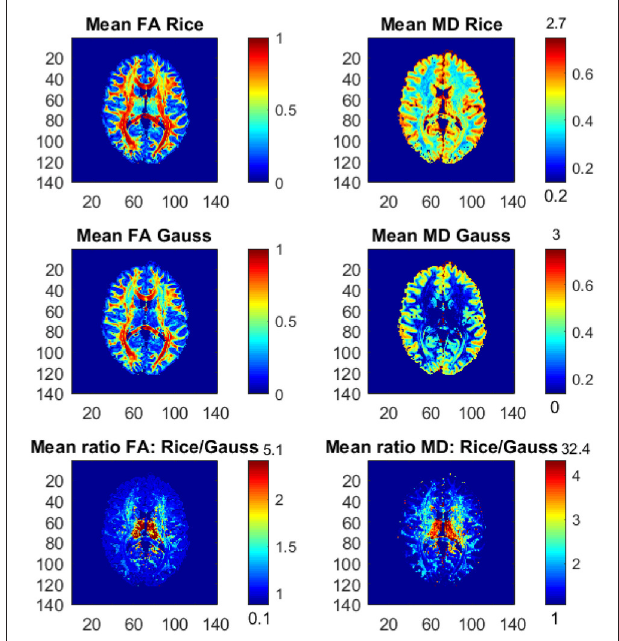
FIGURE 1 | Posterior means and ratios of posterior means of FA and MD for the Rician and Gaussian DTI models, using the whole dataset with all b -values up to b = 10,000 s/mm 2 . The color bars are shown for the mid 95% values and the minimum and maximum values are marked out at the bottom and top of the color bars, respectively.